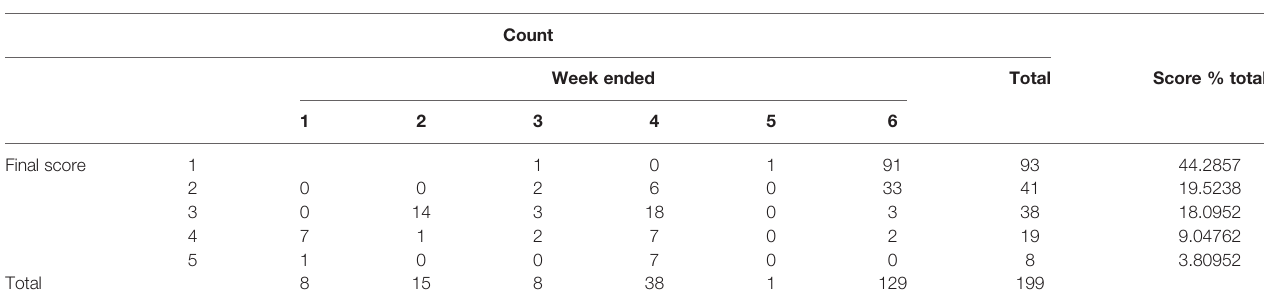
TABLE 1 | Final tick scores of cow population. Final score * Week ended cross tabulation